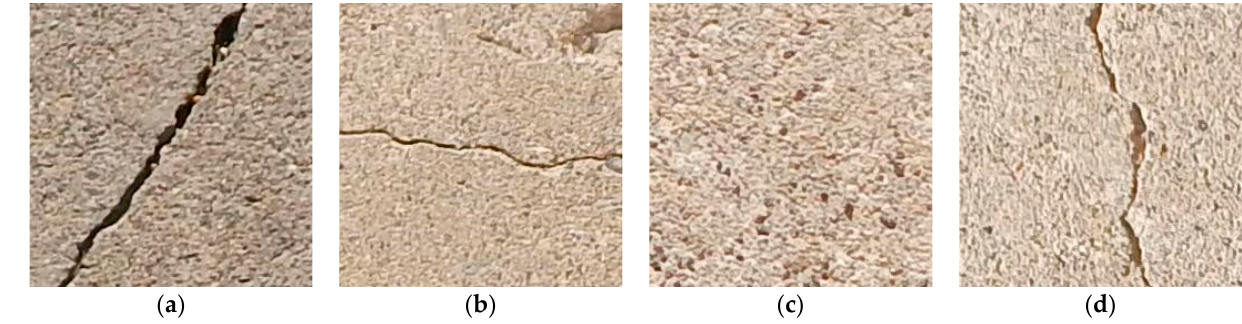
Figure 2. ( a ) Diagonal crack, ( b ) horizontal crack, ( c ) uncracked, ( d ) vertical crack.